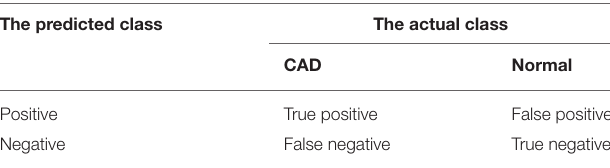
TABLE 6 | Confusion matrix for diagnosis of